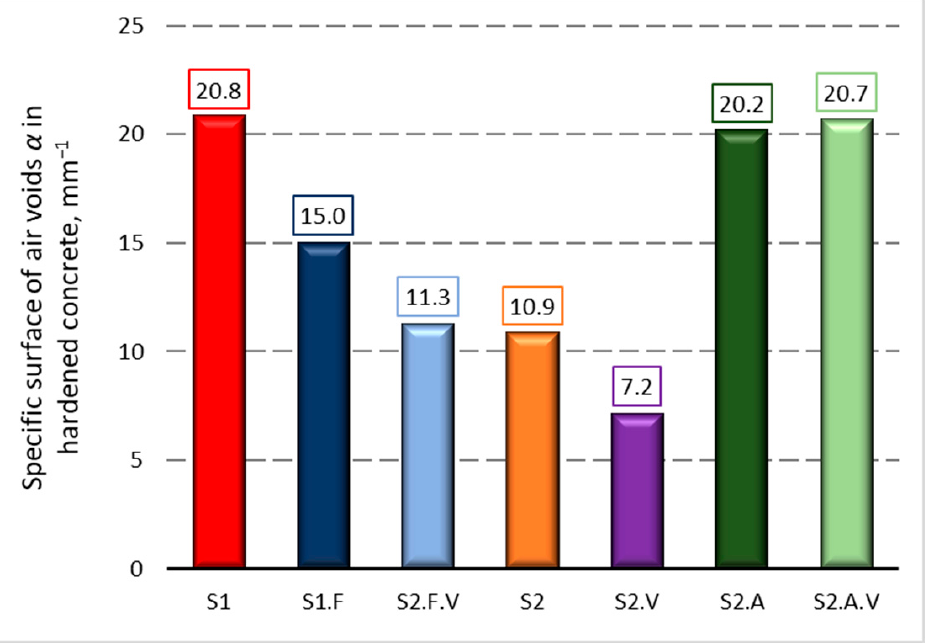
Figure 5. Estimation of specific surface of air voids α in hardened concrete after 28 days of curing.